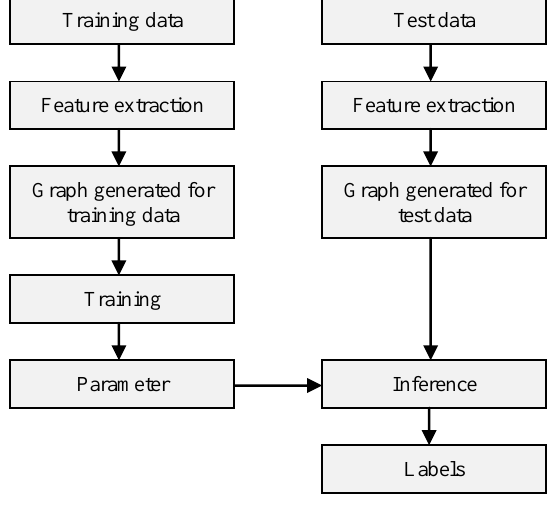
Figure 2: Flowchart of the processing chain for the classification